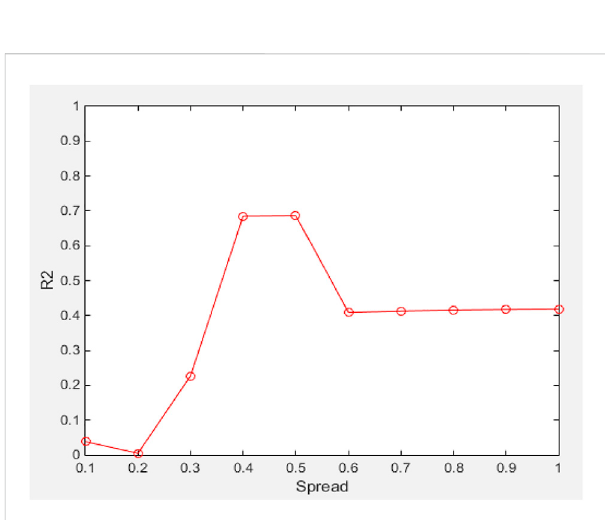
FIGURE 5 In fl uence of spread value on the performance of newrbe radial basis function